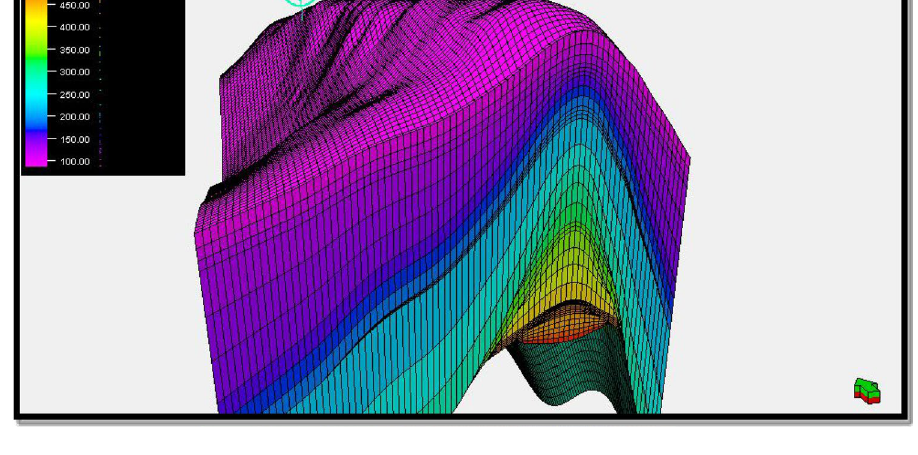
Fig. 22 Maximum horizontal stress